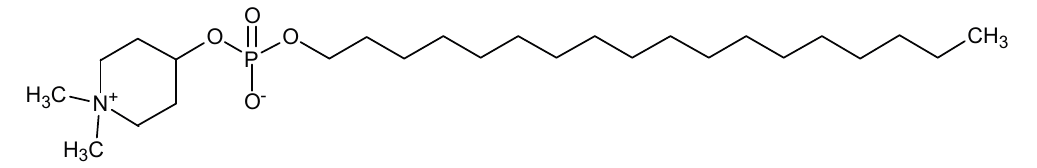
Figure 3. Chemical structures of protein kinase B (Akt) inhibitors with potential activity in diffuse large B-cell